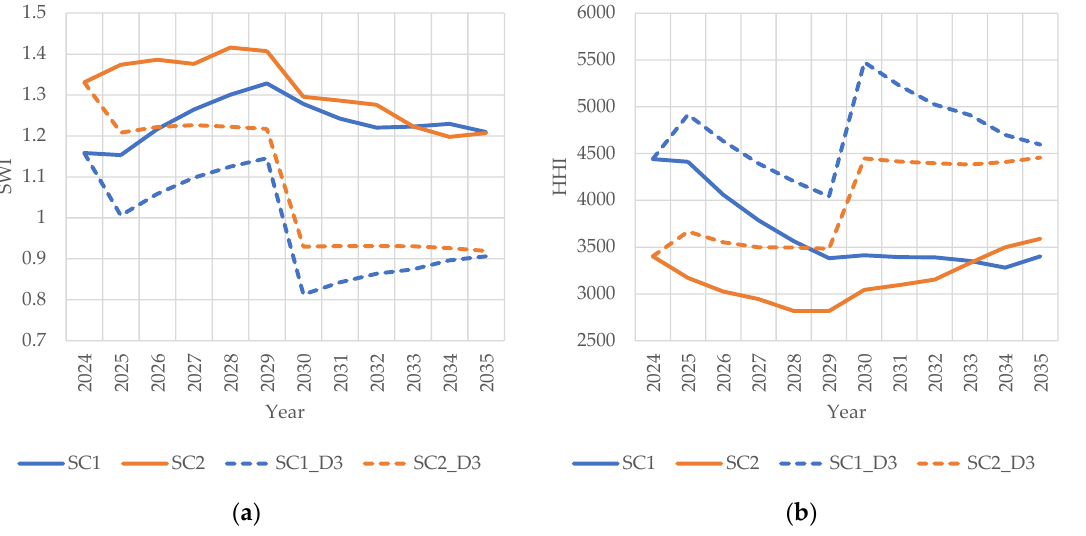
Figure 9. Diversity indicators in the case of the loss of biomass supply: ( a ) SWI; ( b ) HHI.